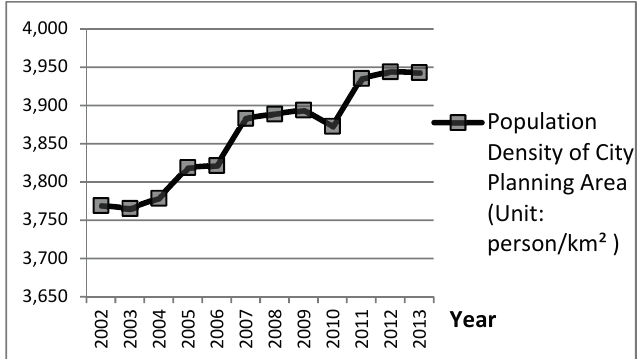
Figure 7. Trend for “Population Density of City Planning Area” in Taiwan’s cities, which directly reveals the cause-and-effect between variables of City Developed Land and City Active Population, 2002 to